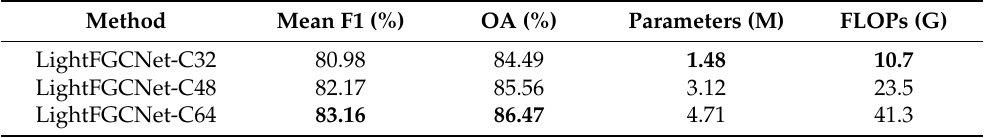
Table 4. Ablation study of the channel number. The bold indicates the best data.